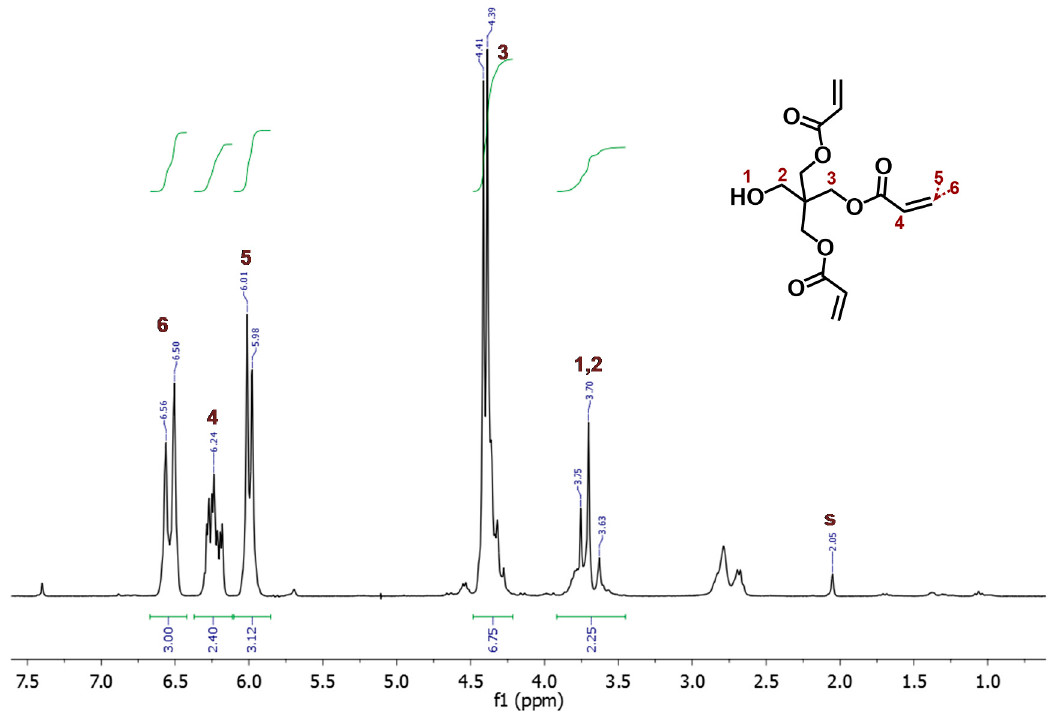
Figure 3. 1 H-NMR spectrum of SR444D in acetone-d 6 . The major component of this commercial product is pentaerythritol triacrylate (PETA), the peaks of which have been marked and integrated.